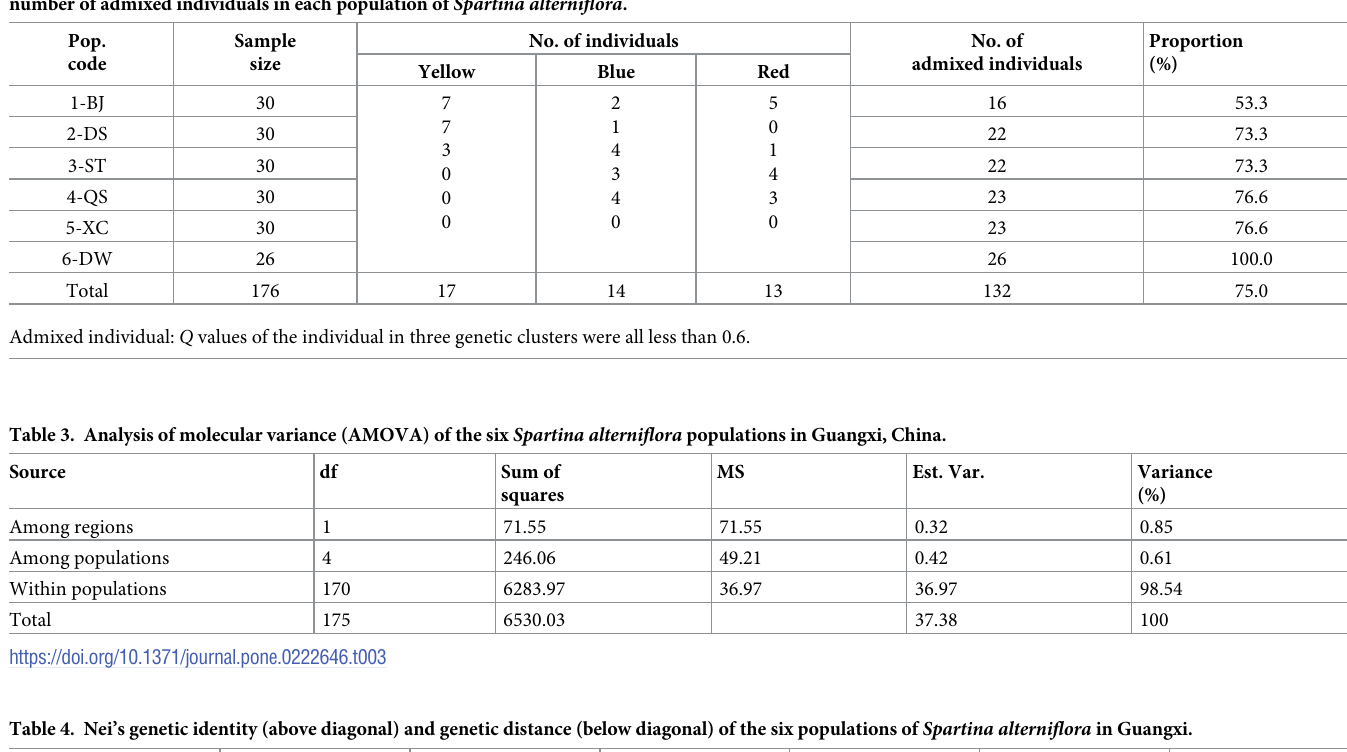
Table 2. The number of individuals with Q � 0.6 to each cluster (three clusters were represented by red, blue and yellow respectively) in the six populations and the number of admixed individuals in each population of Spartina alterniflora . Pop. code